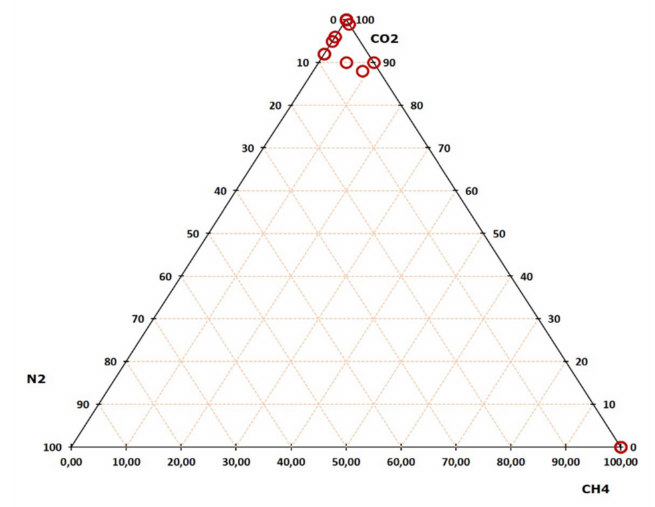
Figure 12. The ternary diagram of CO 2 -CH 4 -N 2